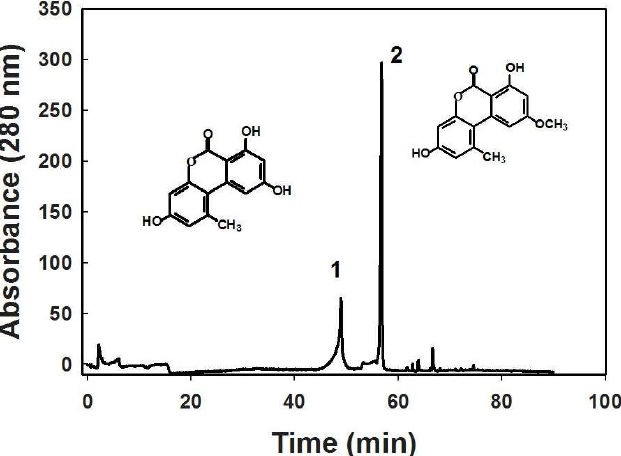
Figure 2. HPLC elution profile of an extract of 15 day-old A. alternata mycelia (Alt14 isolate). 1, alternariol; 2, alternariol monomethyl ether.